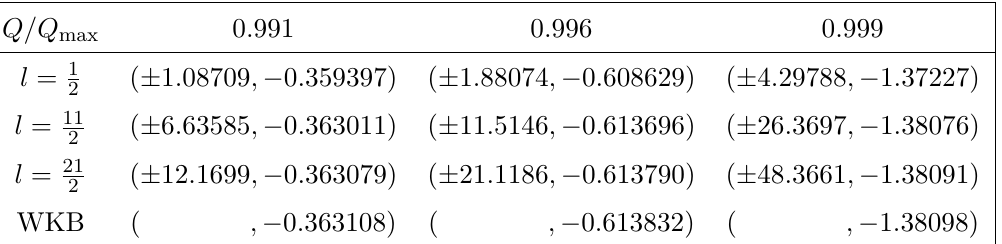
Table 3 . The low-lying QNMs !